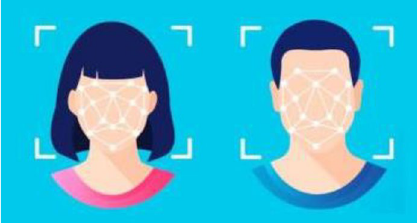
Figure 9. Face recognition matching